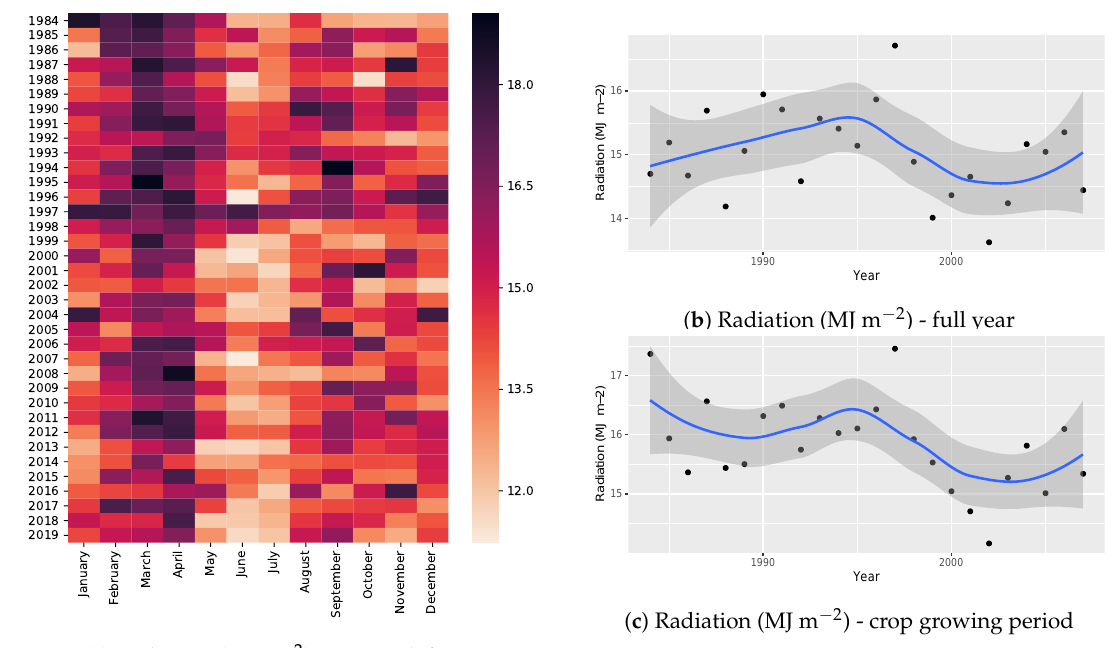
Figure A8. Time series of average radiation (MJ m − 2 ) in Los Rios. ( a ) Heat-map of radiation (MJ m − 2 ) per each month and year from 1984 to 2019. The color scale represents the radiation (MJ m − 2 ). ( b ) Radiation averaged during the full year from 1984 to 2007. ( c ) Radiation averaged during the maize crop growing period in Ecuador (January–May) from 1984 to 2007. Each dot represents one record, the blue line shows the smoothed time series and the shaded area represents the 95% confidence interval.